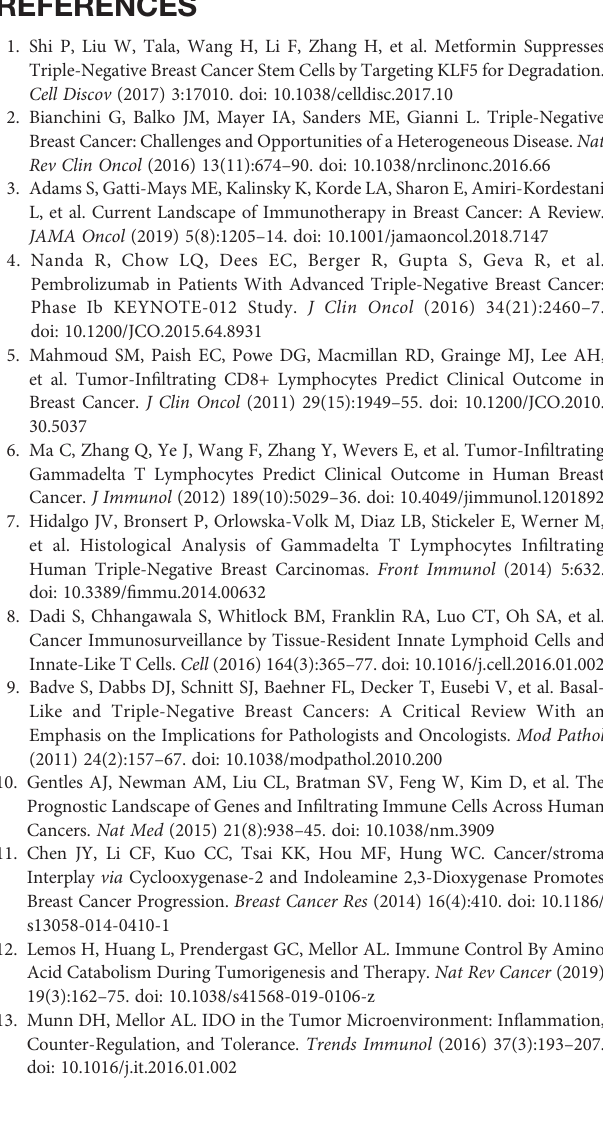
Supplementary Figure 4 | Percentage of NKG2D + , PD-1 + V g 9V d 2 T cells out of the total V g 9V d 2 T lymphocyte population. (A, B) Representative fl ow cytometry plots showing the gating strategy to identify lymphocytes including subsets of V g 9V d 2 T cells expanded from ZOL. (C) V g 9V d 2 T cells were further puri fi ed by negative selection with EasySep ™ Human Gamma/Delta T Cell Isolation Kit. (D, E) V g 9V d 2 T cells were expanded in vitro from the human peripheral blood cells with ZOL. Frequency of NKG2D and PD-1 expression on V g 9V d 2 + T cells at day 12 was shown. Supplementary Figure 5 | Anti-PD-L1 antibody could not further enhance the antitumor ef fi cacy of V g 9V d 2 T cells. (A) Cytotoxicity of V g 9V d 2 T cells toward MCF-7 or MDA-MB-231 cell lines at the indicated ratio of effector to target (E:T). Frequency of dead cells out of whole target cells were showed as PI + . (B) CytotoxicityofV g 9V d 2TcellshadnoobviousdifferenceattheindicatedE:Tratio with MCF-7 or MDA-MB-231 cells (target cells) pretreated with anti-PD-L1 (10 m g/ Supplementary Figure 6 | 1-MT treatment alone did not induce tumor cell apoptosis. (A) IDO1 inhibitor Lindrostat facilitated the cytotoxicity of V g 9V d 2 T cells against MDA-MB-231 cells, but not MCF-7 cells. MCF-7 or MDA-MB-231 cells